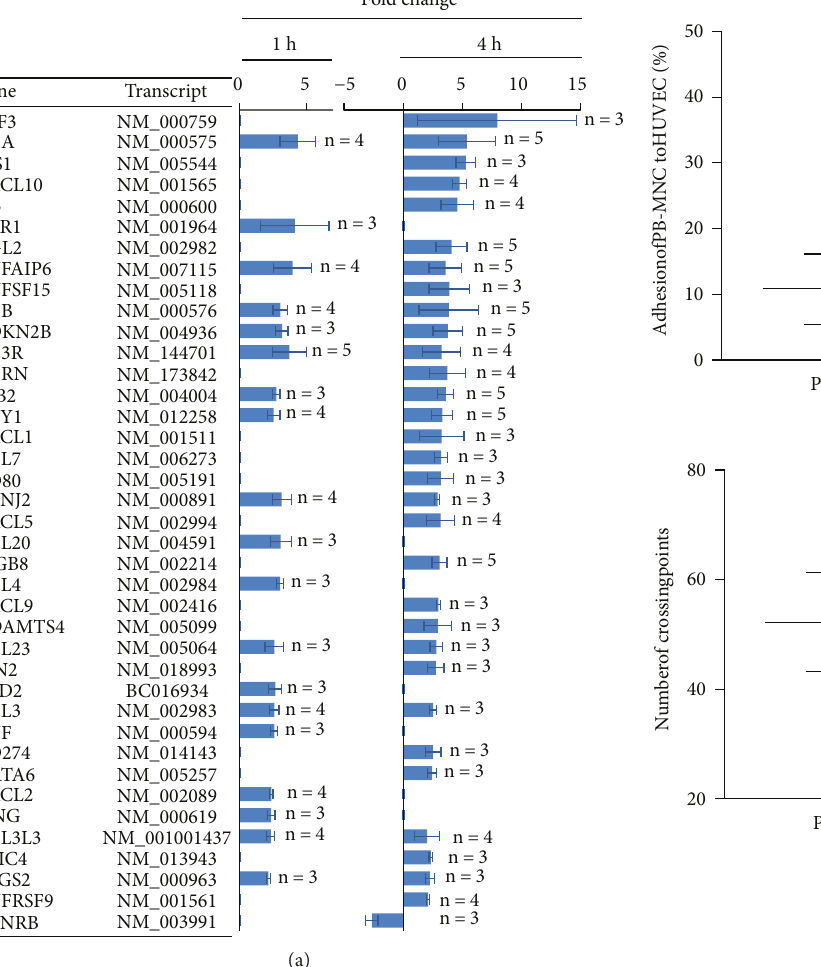
Figure 10: Ephrin-B2 stimulates the expression of genes involved in angiogenesis and in fl ammation of human diabetic PB-MNC. (a) Genes showing upregulated or downregulated expression after one hour (left graph) or four hours (right graph), in three or more of the total fi ve samples per time point, are listed in descending order according to the average change in expression levels following ephrin-B2 stimulation. For a human gene to be considered signi fi cantly upregulated or downregulated by ephrin-B2, expression in the human array had to be at least twofold higher or lower, respectively. Figures to the right of the outer edge of bars indicate the number of patients in whom gene expression was signi fi cantly changed at both time points ( N = 5 ). (b) Percentage adhesion of ephrin-B2-stimulated PB-MNC to HUVEC monolayer was increased 3.5-fold in adherent cells ( N = 10 /group). Data are presented as % adhesion ± HdSD. (c) Capillary- like tube formation assay on Matrigel. The number of branch points was signi fi cantly greater in the PB-MNC+ compared to PB-MNC groups ( N = 7 /group). Data are presented as mean ± SD. ∗ P < 0 05 ; ∗∗∗ P < 0 001